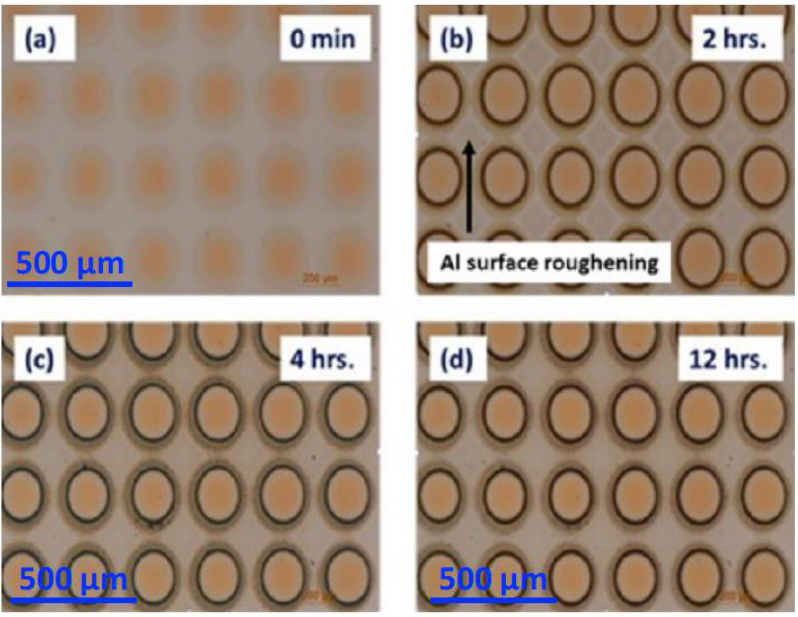
Figure 7. Micropattern corrosion screening of Al/Cu bimetallic contact immersed in 5 ppm F − solution at pH 5. The images were taken at ( a ) 0 h after immersion; ( b ) immersion time = 2 h, ( c ) 4 h, ( d ) 12 h.